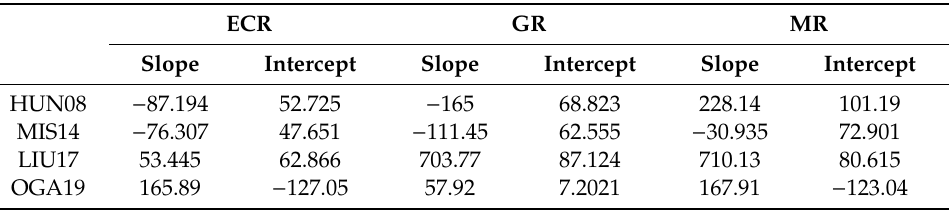
Table 4. Algorithm’s coe ffi cients resulting from